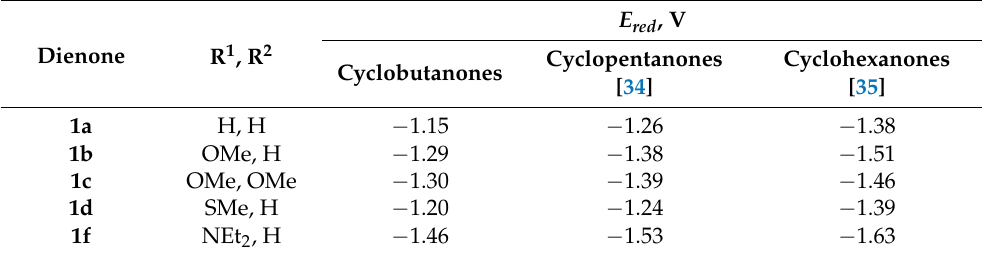
Table 3. Electrochemical potentials of dibenzylidene cyclobutanones 1a – d , f and previously studied cyclopentanone and cyclohexanone derivatives with the same substituents measured in MeCN under the same conditions (Ag/AgCl/KCl(sat.) in the presence of 0.1 M Bu 4 NClO 4 on a GC electrode at a potential sweep rate of 100 mV s − 1 ).